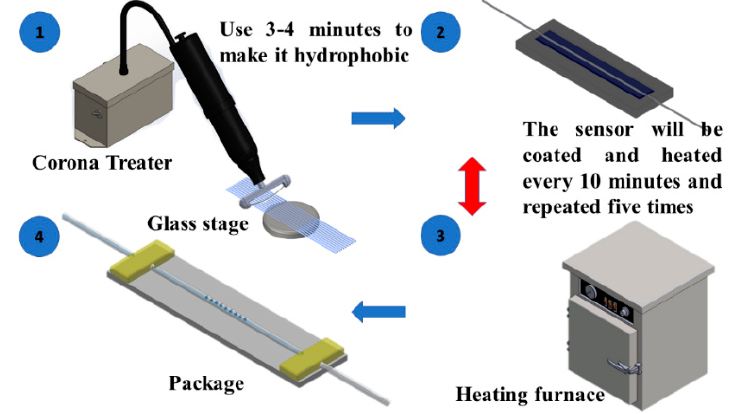
Figure 4. Schematic of the LPFG sensor detailing the process of the polymer coating.